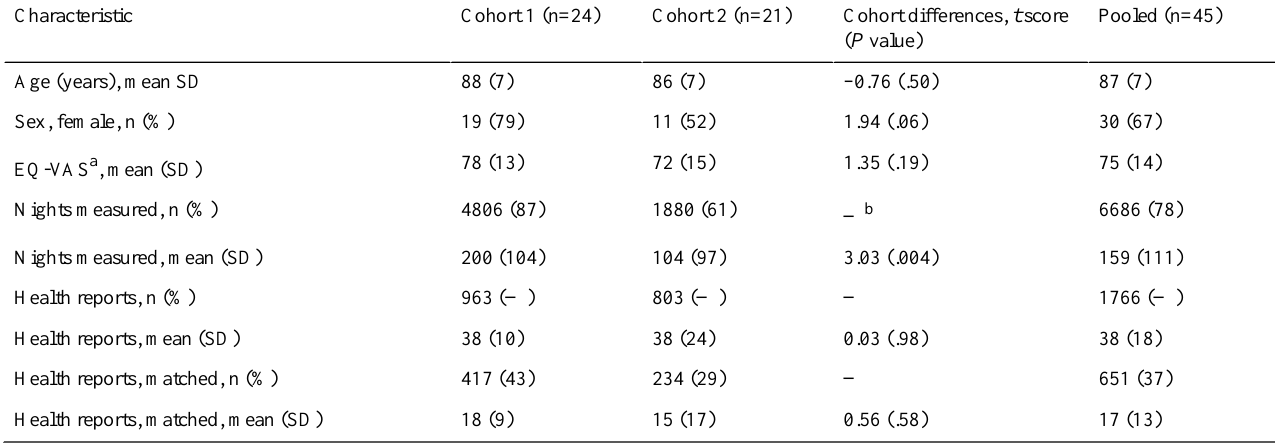
Table 1. Participant and questionnaire characteristics.